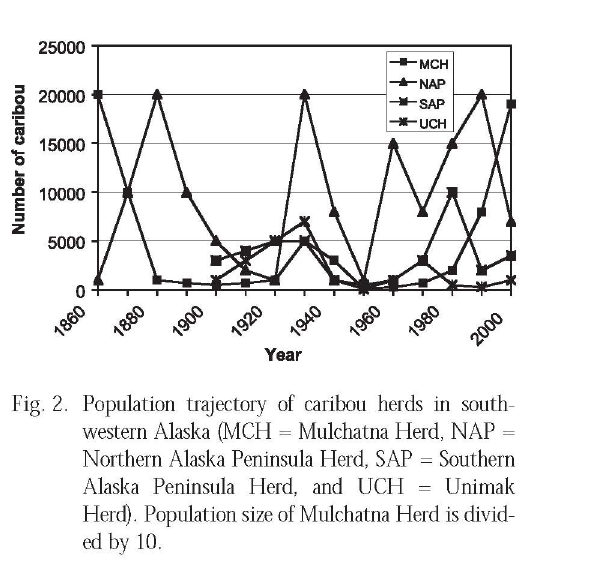
Fig. 2. Population trajectory of caribou herds in south western Alaska (MCH = Mulchatna Herd, NAP = Northern Alaska Peninsula Herd, SAP = Southern Alaska Peninsula Herd, and UCH = Unimak Herd). Population size of Mulchatna Herd is divid¬ ed by